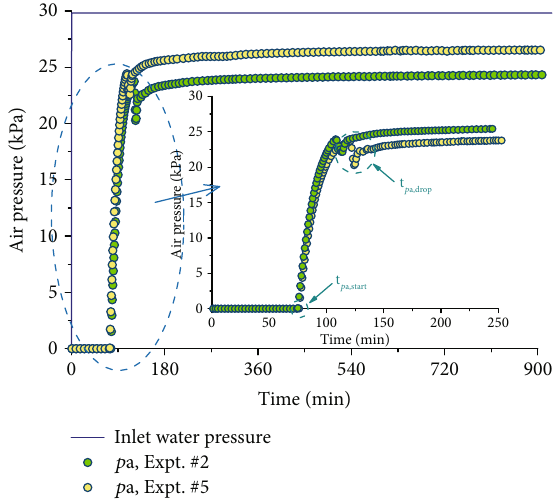
Figure 6: The comparison of air pressure (at the column end) between Expt. #2 and Expt. #5, shown at two time